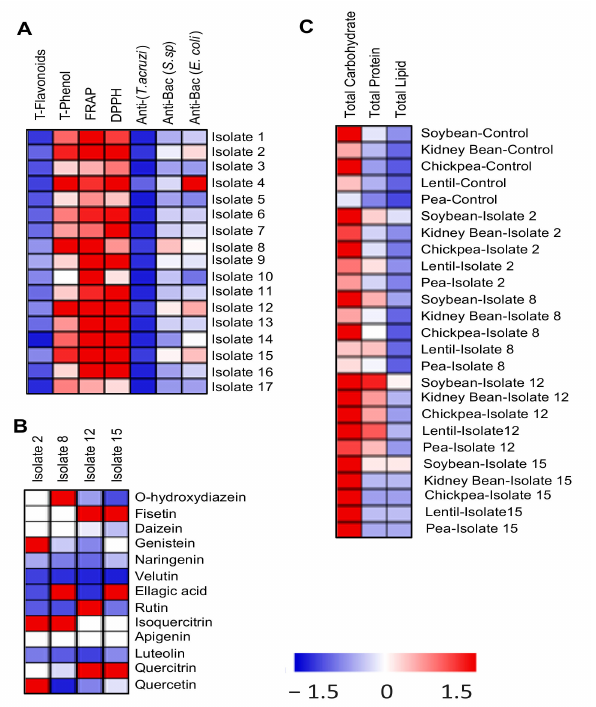
Figure 2. ( A ) Heatmap showing the results of screening of the di ff erent actinomycete isolates isolated from local legume fields for their biological activity as indicated by their total flavonoids and phenolics content, total antioxidant capacity measured by FRAP and DPPH assays, as well as their antiprotozoal activities. ( B ) The flavonoid profile in the four selected actinomycete isolates. ( C ) The changes in total carbohydrates, proteins, and lipids in grains of the selected legumes upon soil enrichment with biologically active